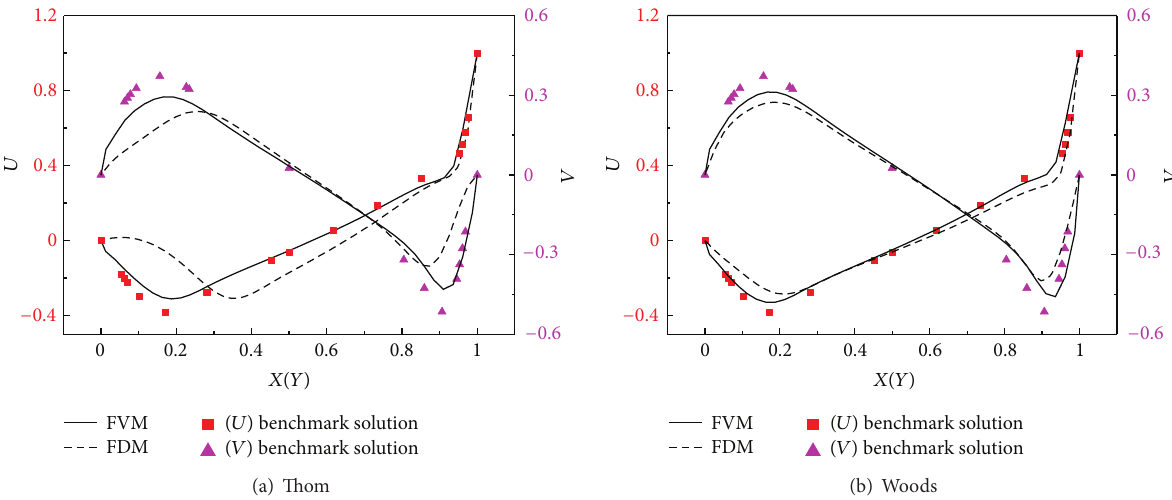
Figure 4: Velocity along the central axis obtained by second-order central difference scheme with two treatments of boundary condition when the mesh density is 40 × 40